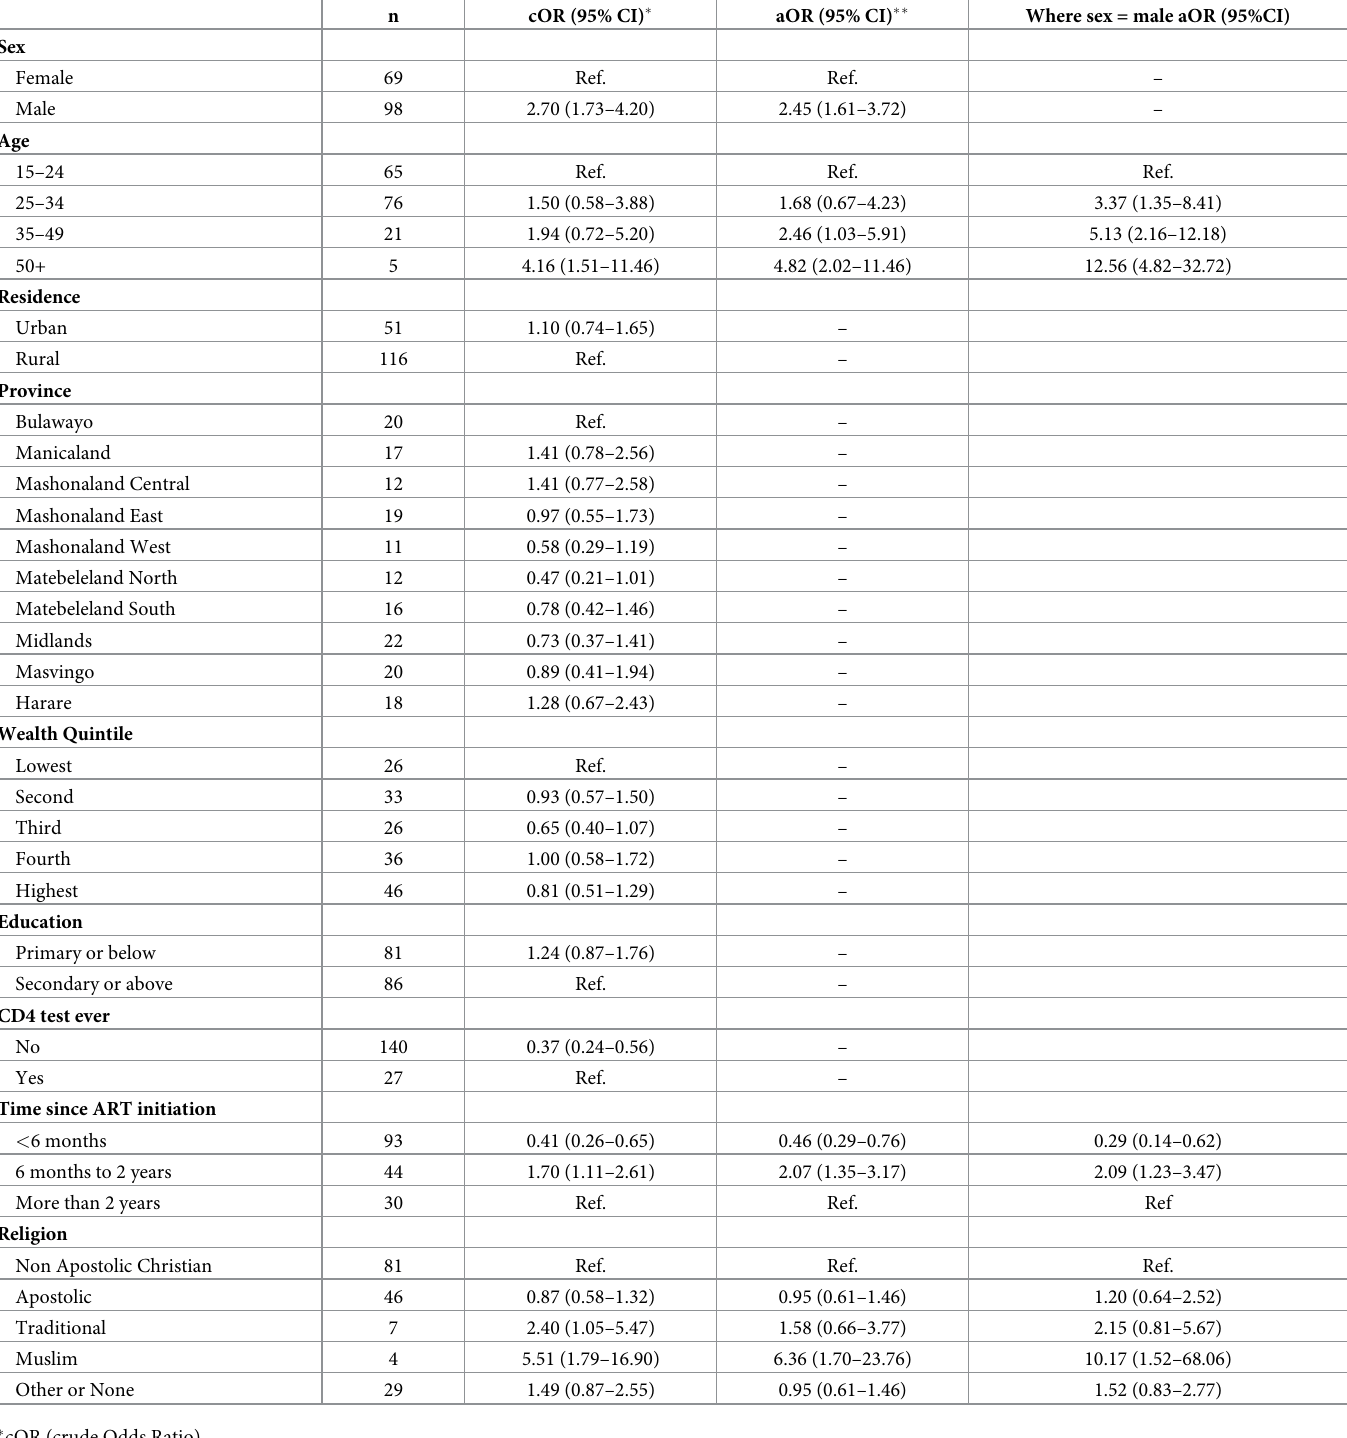
Table 3. Results of univariate and multivariable models illustrating factors associated with advanced HIV disease and concurrent suppressed viral load (n = 167) and further restricted to male